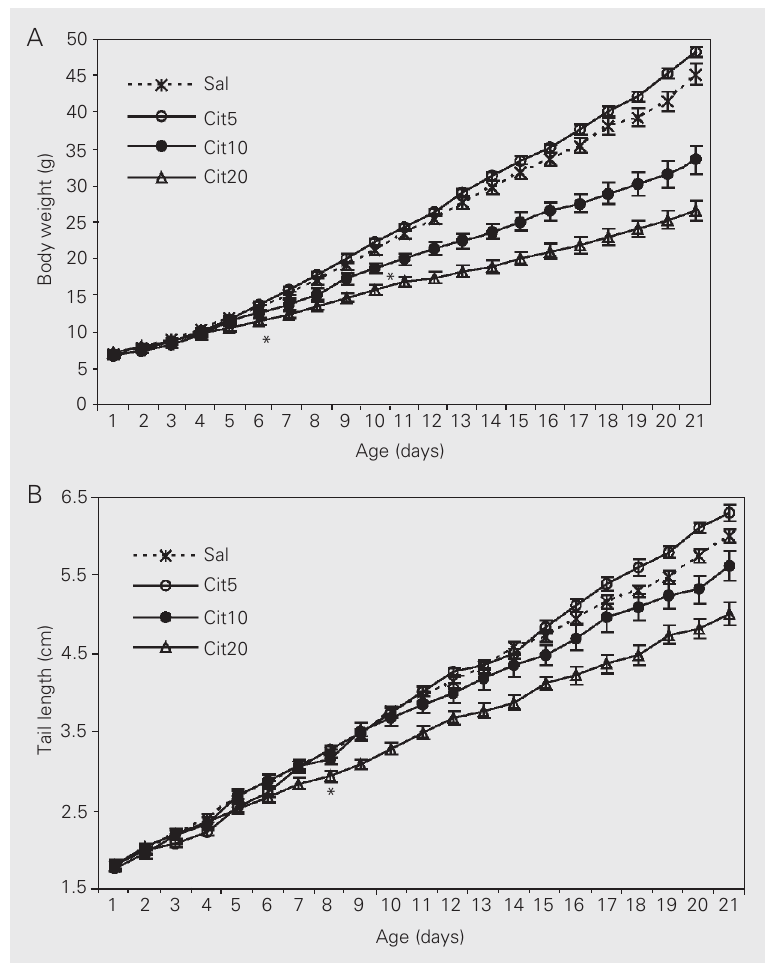
Figure 1. Effect of citalopram on suckling rat weight and tail length. A , Body weight from the 1st to the 21st day of life of suckling rats treated with solutions (1 ml/100 g body weight, sc ) of citalopram: 5 mg (Cit5, N = 26), 10 mg (Cit10, N = 27) and 20 mg/kg (Cit20, N = 26) or saline (Sal, N = 27). Comparisons were made by two-way ANOVA for repeated measures: citalopram (F 3,102 = 52.9, P < 0.001), day of life (F 20,2040 = 2340.6, P < 0.001), and citalopram versus day of life interaction (F 60,2040 = 69.5, P < 0.001) followed by post hoc multiple comparisons (Tukey test) between each citalopram dose and saline: *P < 0.001. Each point represents the mean values according to the dose. The asterisks indicate the beginning of significant differences (P < 0.01) that persisted through the end of the experiment. B , Tail length. Comparisons were made by two-way ANOVA for repeated measures: citalopram (F 3,102 = 13.7, P < 0.001), day of life (F 20,2040 = 3198.0, P < 0.001), and citalopram versus day of life interaction (F 60,2040 = 18.7, P < 0.001) followed by post hoc multiple comparisons (Tukey test) between each citalopram dose and saline: each point represents the mean values according to the dose. The asterisk indicates the beginning of significant differences (P < 0.01) which persisted to the end of the experiment according to the